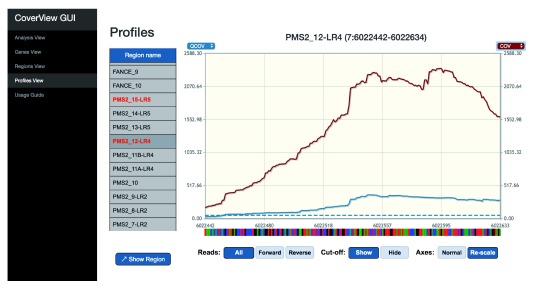
CoverView GUI Profiles View showing
PMS2 exon 12 COV and QCOV data in GIAB sample.CoverView GUI screenshot of Profiles View for
PMS2 exon 12 data in the GIAB sample showing the quality coverage QCOV (blue), per-base coverage COV (red) and the minimum QCOV threshold as dashed horizontal lines, across the region. The useful (quality) coverage is only a small proportion of the total coverage.